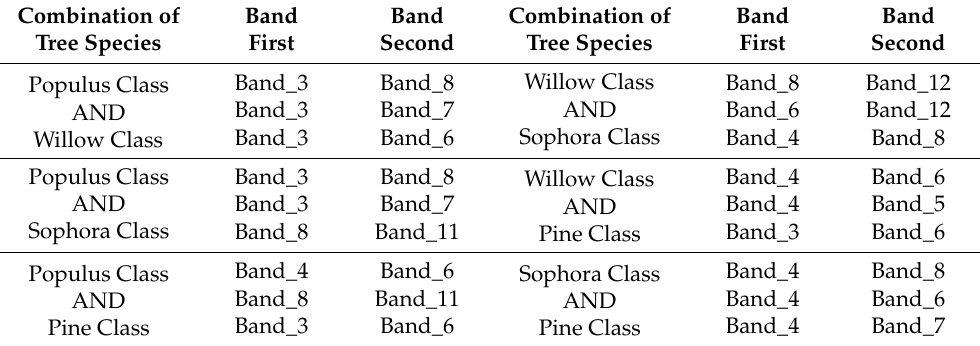
Table 5. Band combinations for the constructed normalized difference